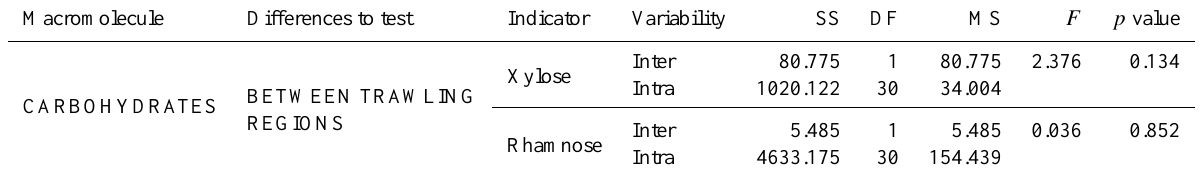
Table 2d. Results of the statistical test one-way ANOVA for carbohydrates (xylose and rhamnose). Significant differences are in bold. Macromolecule Differences to test Indicator Variability SS DF MS F p value Inter Xylose BETWEEN TRAWLING CARBOHYDRATES